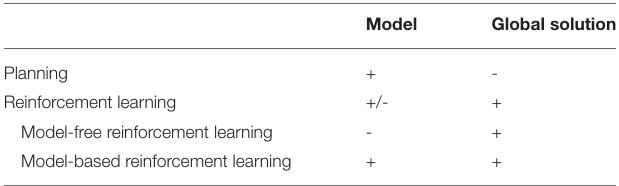
TABLE 1 | Categorization of planning and reinforcement learning, based on 1) the presence of a model (settable/reversible access to the MDP to the MDP dynamics), and 2) the presence of a global/learned